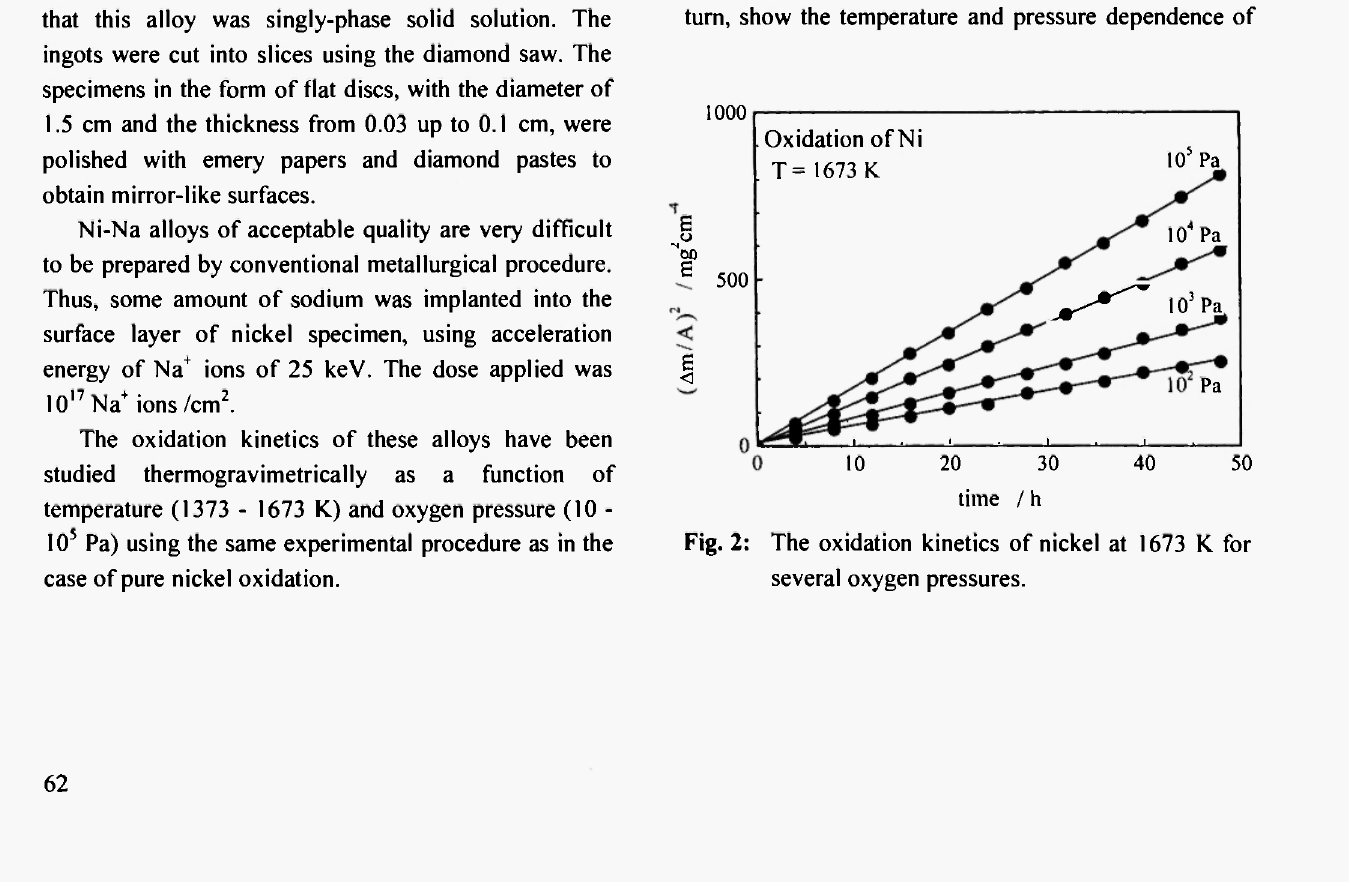
Fig. 2: The oxidation kinetics of nickel at 1673 Κ for several oxygen